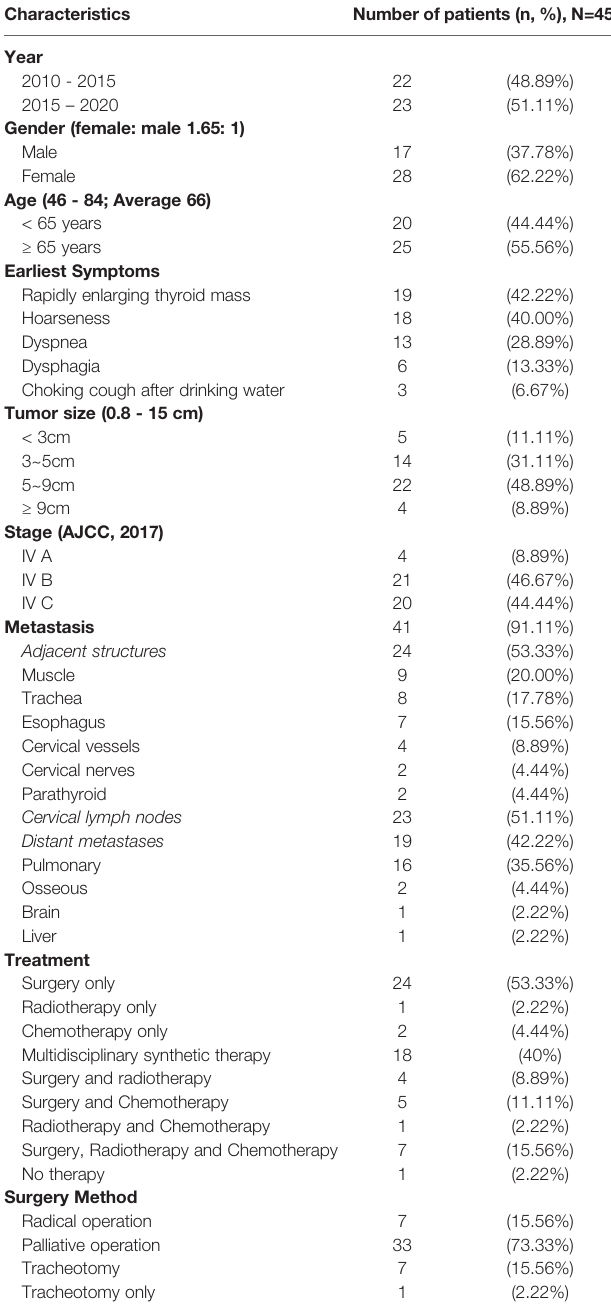
TABLE 2 | General characteristics, tumor stage and treatment.